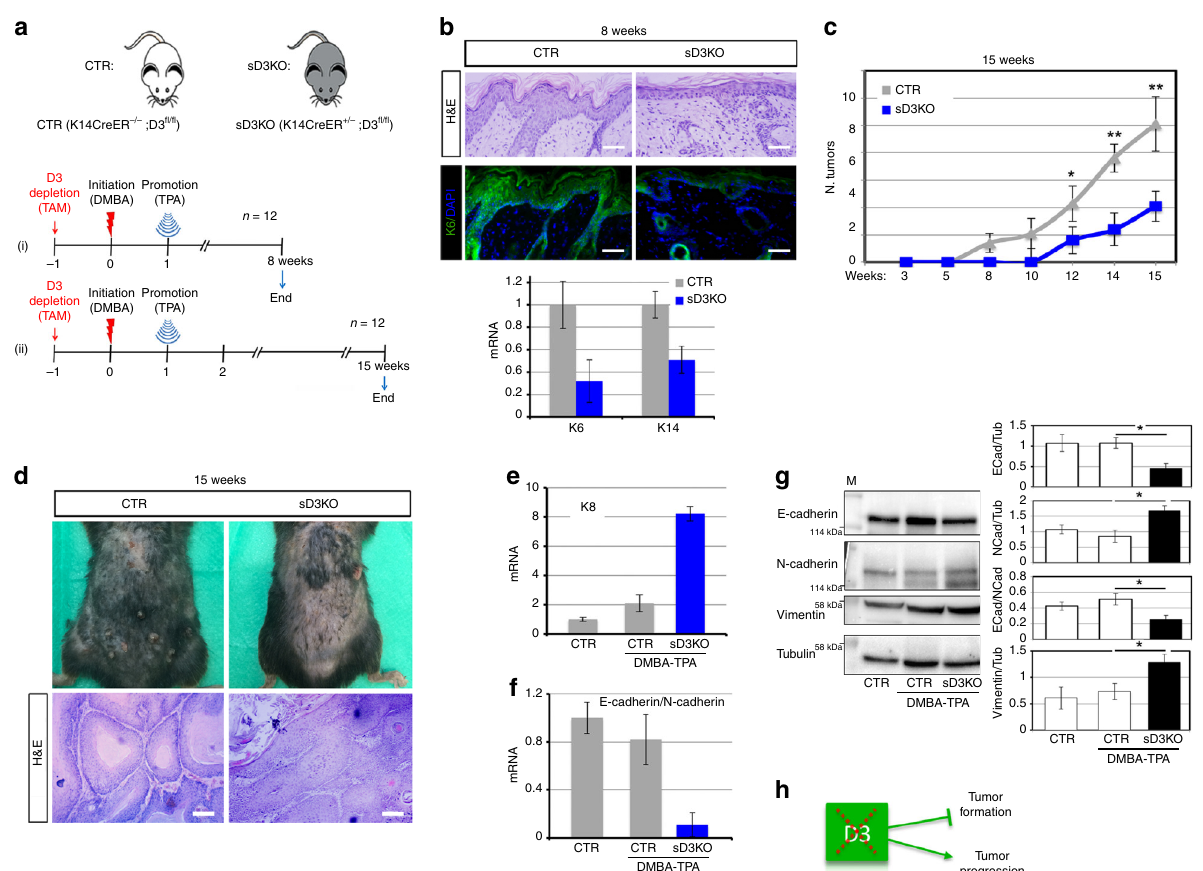
Fig. 2 Increased thyroid hormone action in epidermal-speci fi c D3KO mice enhanced the migration and invasion potential of SCC. a Schematic representation of D3-depletion and the two-step carcinogenesis experiment in 12 CTR and 12 sD3KO samples ( n = 12). b Representative H&E and K6 staining of DMBA-TPA-treated CTR ( n = 8) and sD3KO ( n = 8) skins for 8 weeks. Scale bar represents 200 μ m (top). mRNA levels of K6 and K14 were measured by real-time PCR analysis in 16 lesions from CTR mice and 16 lesions from sD3KO mice (bottom). c The number of skin lesions was counted during the two-step carcinogenesis experiment as indicated in a (ii). Tumor incidence is expressed as the number of tumors per mouse. d Representative images of the dorsal skin from CTR and sD3KO mice treated with DMBA-TPA for 15 weeks ( n = 12). H&E of the skin lesions from CTR ( n = 6) and sD3KO ( n = 6) mice treated with DMBA-TPA for 15 weeks. Scale bar represents 200 μ m. e mRNA levels of K8 in the dorsal skin of CTR ( n = 15) and sD3KO ( n = 15) mice. f mRNA levels of E-cadherin/N-cadherin in skin lesions of CTR ( n = 15) and sD3KO ( n = 15) mice measured by real-time PCR analysis. g Western blot analysis of E-cadherin, N-cadherin, and vimentin expression in skin lesions of CTR ( n = 10) and sD3KO mice ( n = 10). Quanti fi cation of the single protein levels versus tubulin levels and the E-cadherin/N-cadherin ratio is represented by histograms. * P < 0.05, ** P < 0.01. h Schematic representation of the effects of D3-depletion on SCC tumor growth and